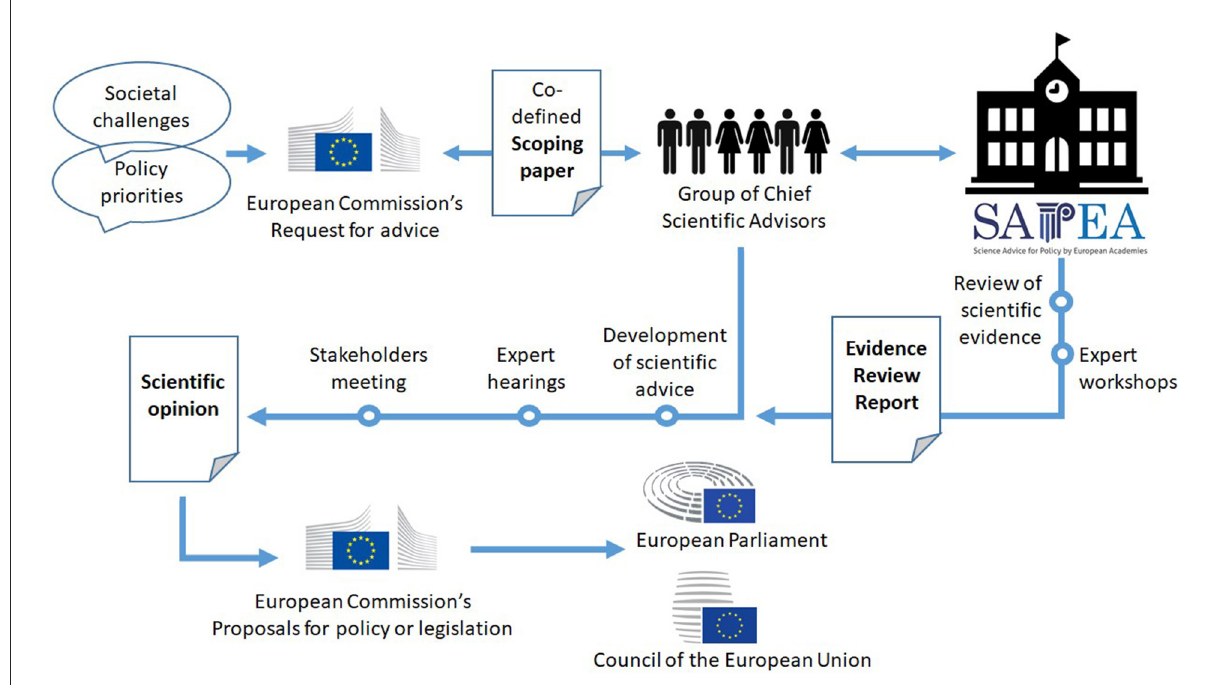
FIGURE1 Simplified process of the EU’s Science Advice Mechanism (SAM), adapted from https://ec.europa.eu/info/research-and-innovation/strategy/